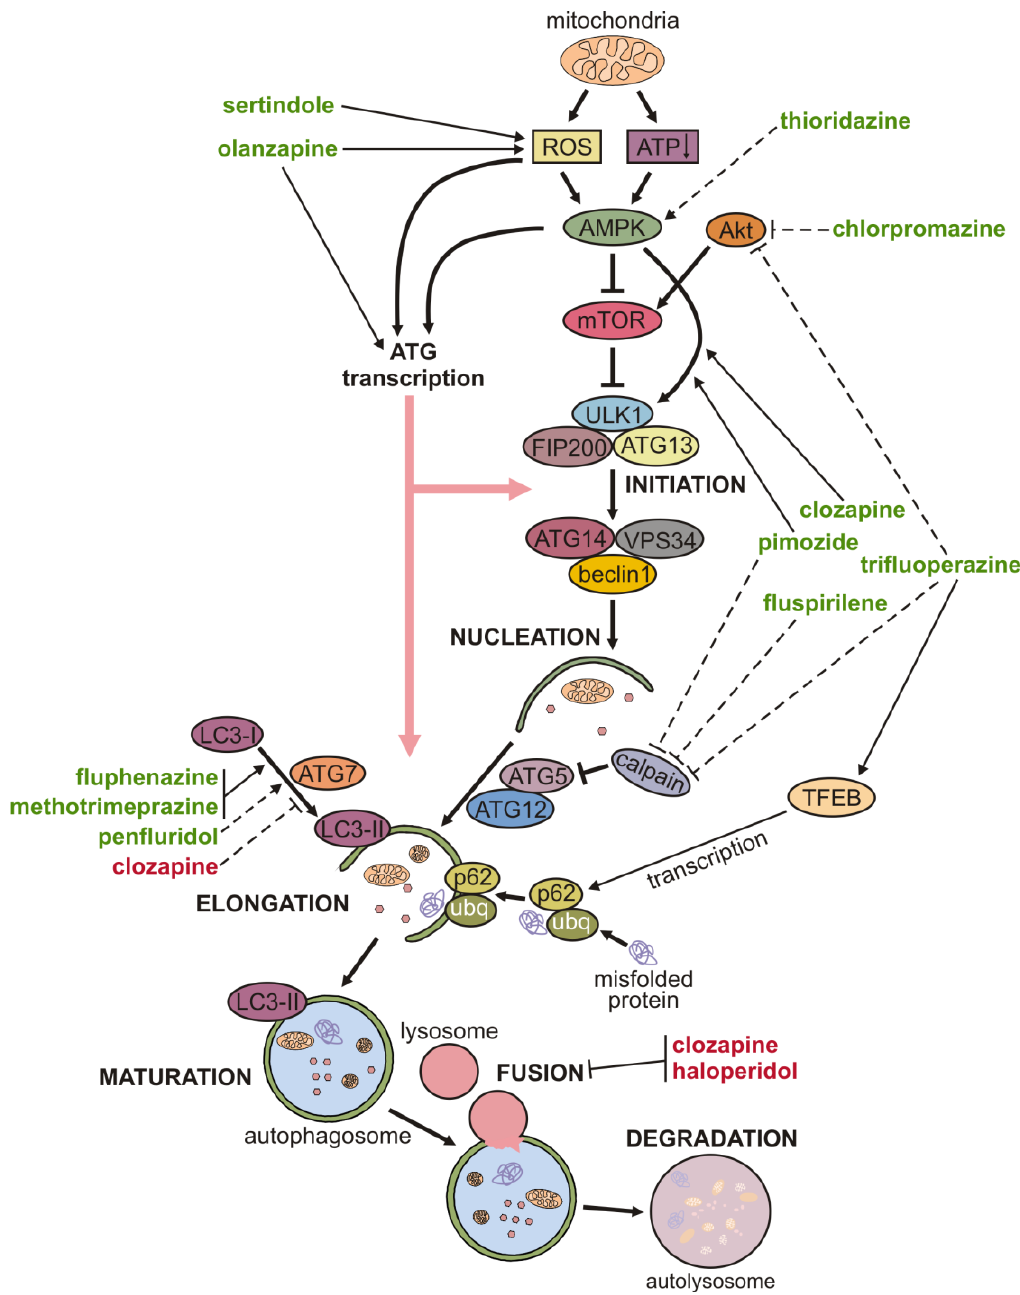
Figure 1: Mechanisms of autophagy regulation by antipsychotics. A simplified map of autophagy regulation is presented, including the sites of action of antipsychotic drugs shown as arrow-headed (activation/increase) or bar-headed lines (inhibition/decrease). The full and dashed lines refer to modulation in neurons/brain and non-neuronal cells, respectively. The drug names are marked green for autophagy stimulation, or red for autophagy inhibition. Some drugs are shown to directly modulate LC3 conversion only because no specific underly- ing mechanism was described. (ubq –